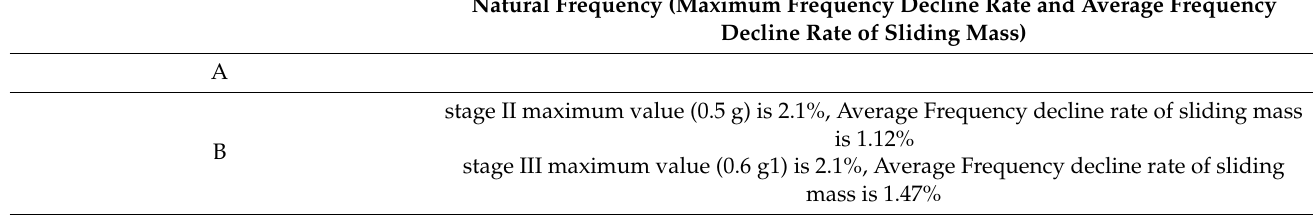
Table 9. Natural